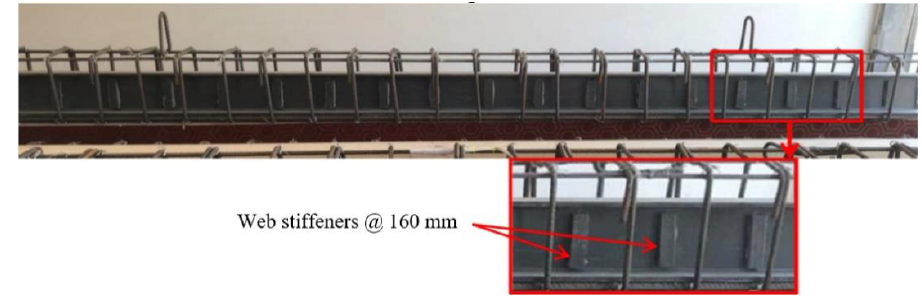
Figure 3. GFRP I-beams with reinforcement and web stiffener.